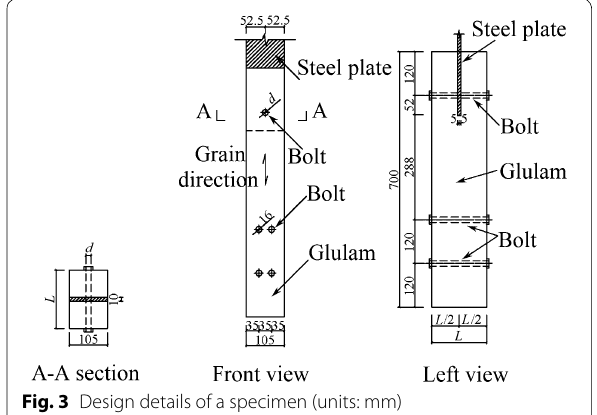
Fig. 3 Design details of a specimen (units: